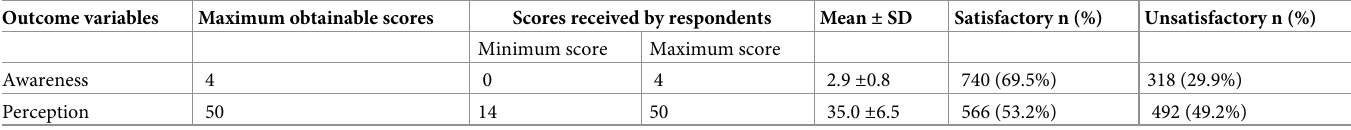
Table 2. Description of outcome variable scores obtained by respondents (n = 1058).